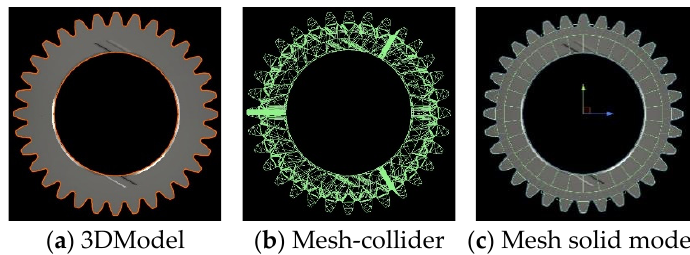
Figure 8. Process and mesh solid model for detecting the inner contour.